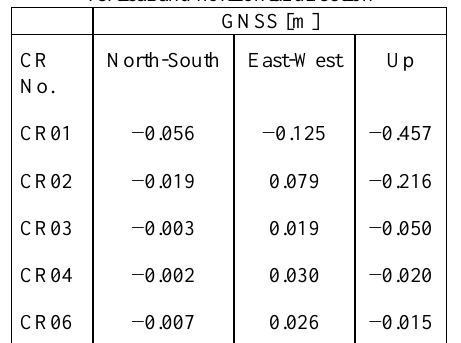
Table 2. Estimated deformation from GNSS measurement